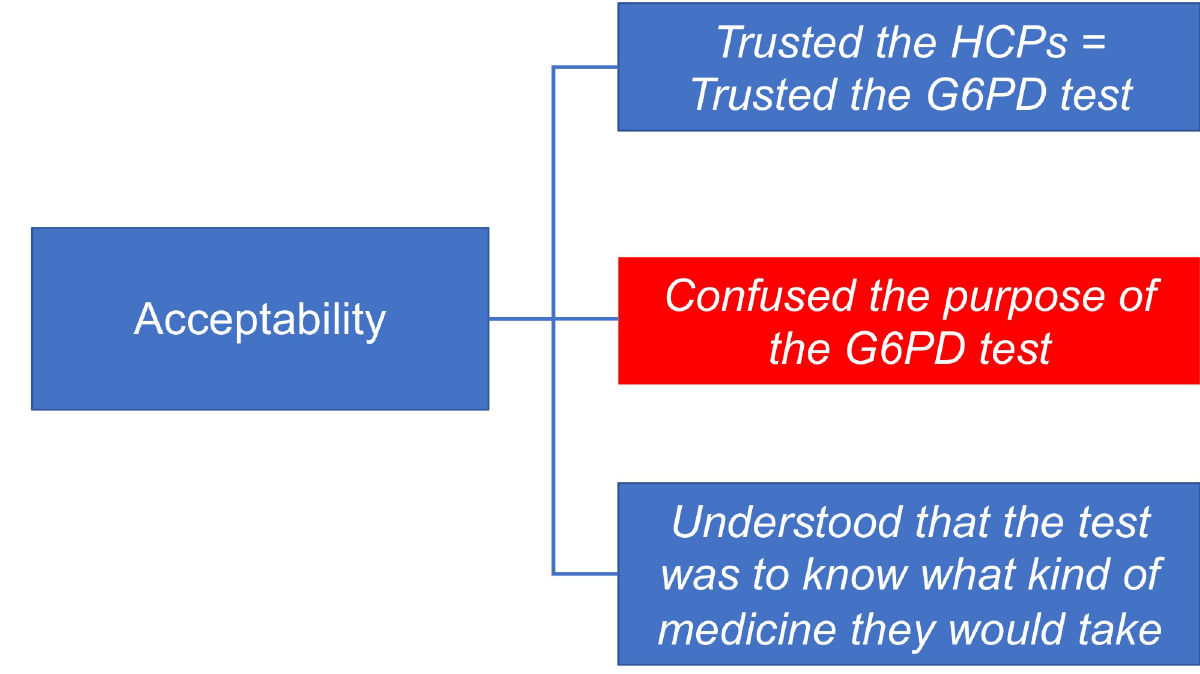
Fig 4. Patient acceptability of the test. Blue and red boxes show reasons for trusting and barriers to the test, respectively.